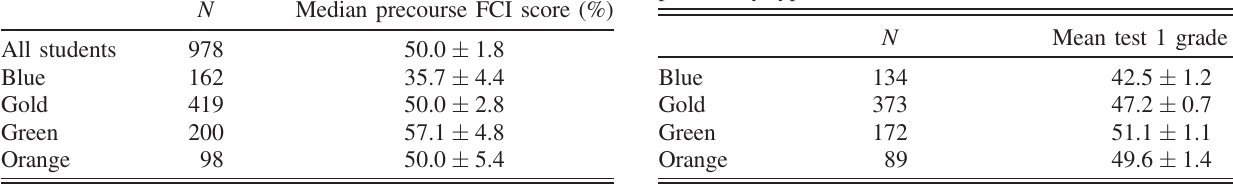
TABLE VII. Mean test 1 grade for students with a dominant personality